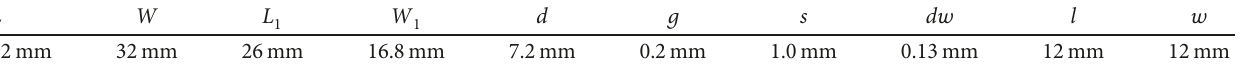
Table 1: Antenna geometry parameters.